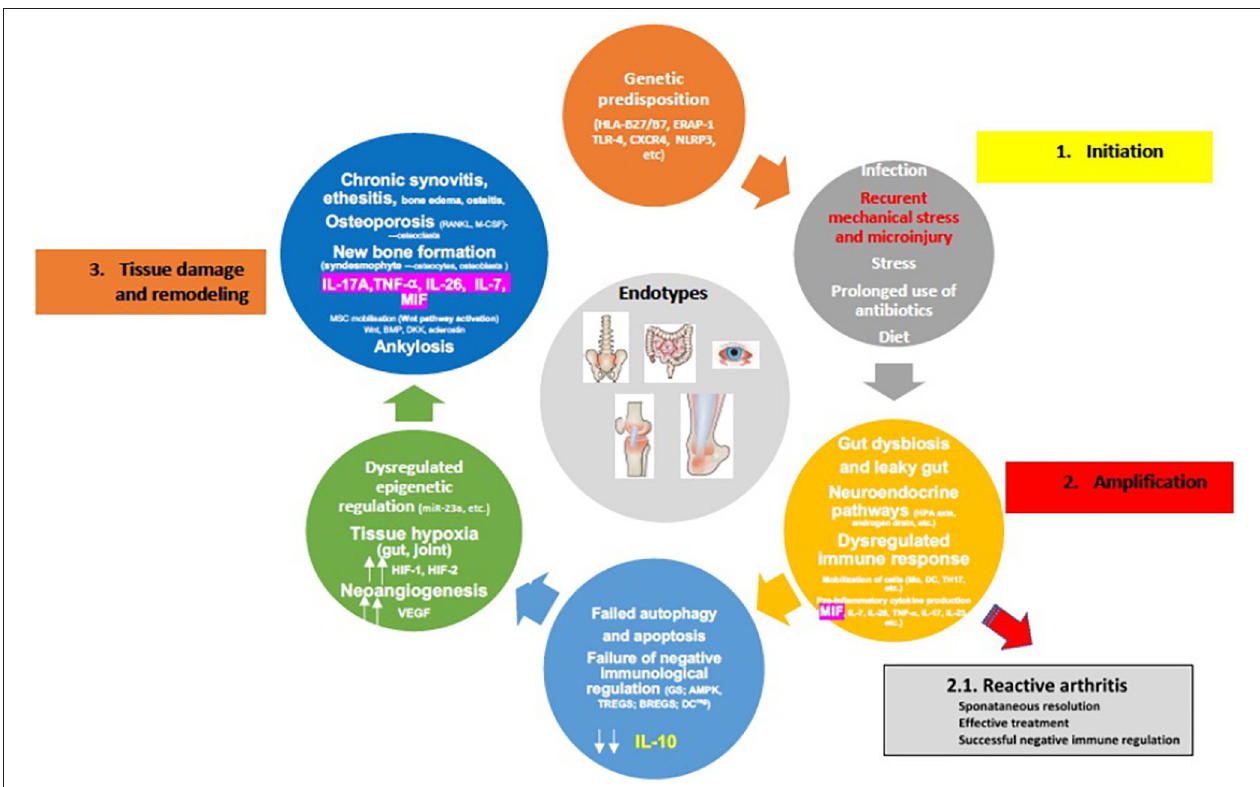
FIGURE 4 | Proposed pathophysiology of spondyloarthritis development (for details please see text). [Adopted modified from